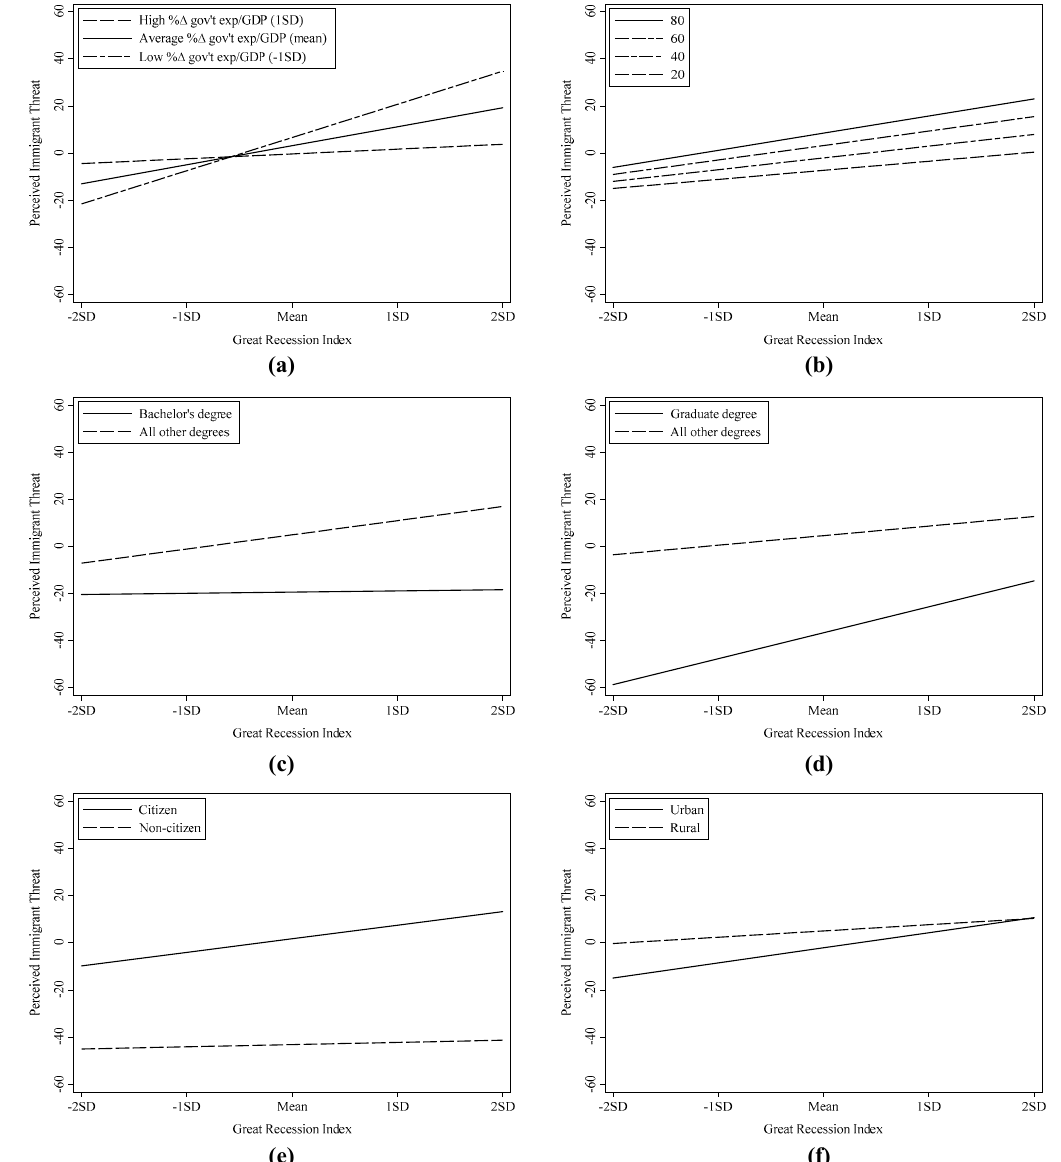
Figure 1. Interaction effects of the Great Recession on perceived immigrant threat: ( a ) % ∆ government expenditures/GDP; ( b ) age; ( c ) bachelor’s degree; ( d ) graduate degree; ( e ) citizen; ( f ) urban.